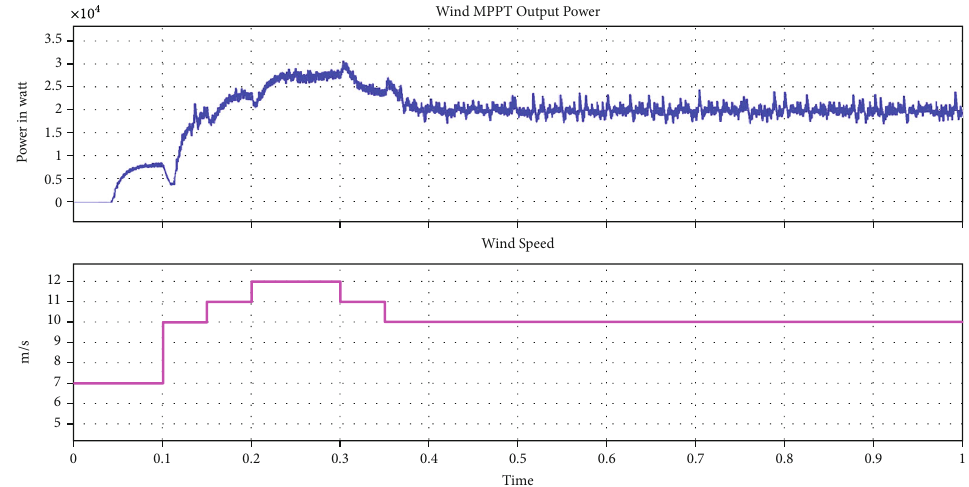
Figure 18: Simulation results of DNN-wind MPPT power (for di ff erent wind speeds).